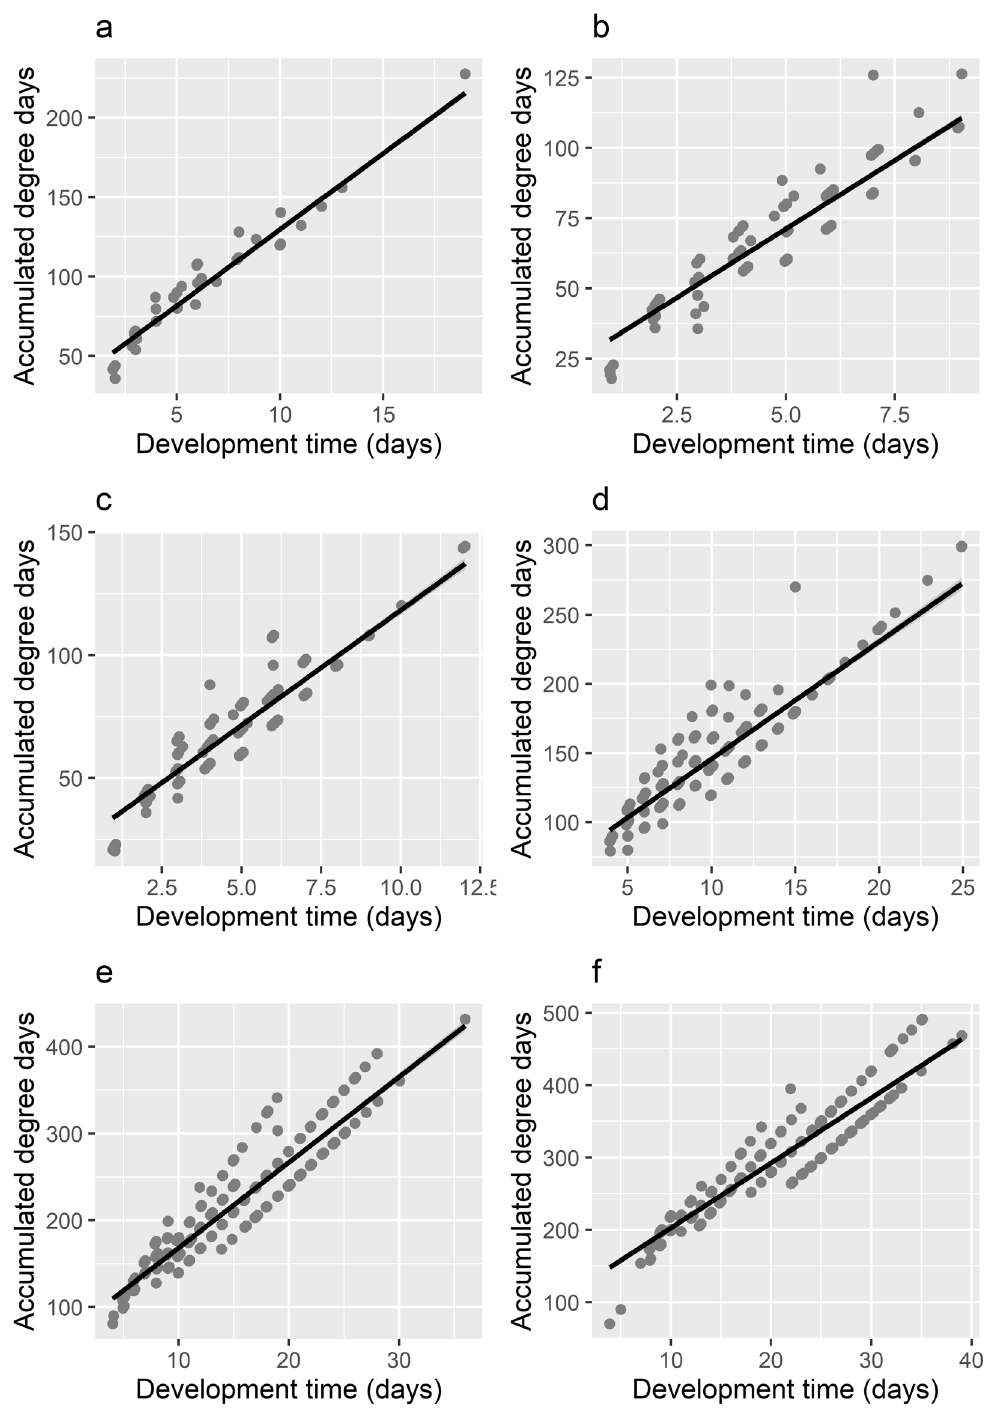
Figure 1. Ikemoto and Takai 30 thermal summation model for all developmental stages of T. rugosus : ( a )